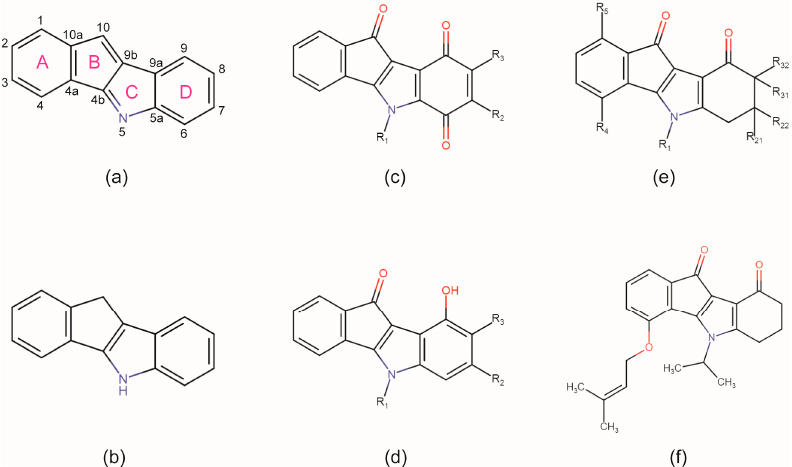
Figure 1. The indeno[1,2- b ]indole framework with atom and ring labels ( a ), its reduced form ( b ) and some of its substitution possibilities to create effective CK2 inhibitors. ( c – e ) The quinonic ( c ), phenolic ( d ) and ketonic ( e ) cluster of indeno[1,2- b ]indole-type CK2 inhibitor candidates as defined by Haidar et al. [56]. ( f ) The CK2 inhibitor 5-isopropyl-4-(3-methylbut-2-enyloxy)-5,6,7,8-tetrahydro-indeno[1,2- b ]indole-9,10-dione ( 4p ), described by Gozzi et al. [52] and used for the experiments of this study.